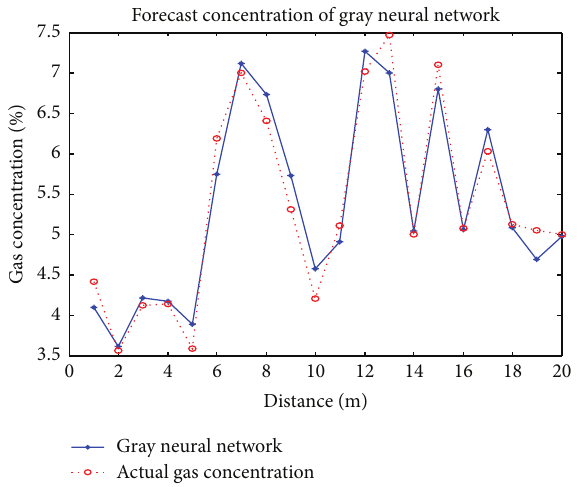
Figure 11: Forecast output of the gray neural network optimized by the quantum genetic algorithm.